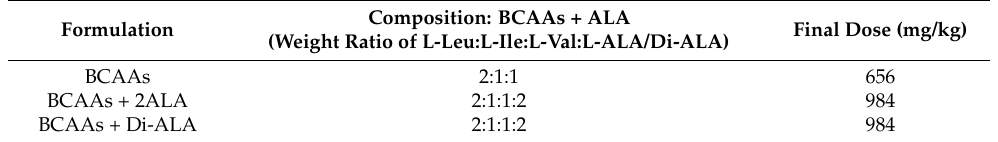
Table 1. Composition and daily final dose (mg/kg) for each tested formulation.